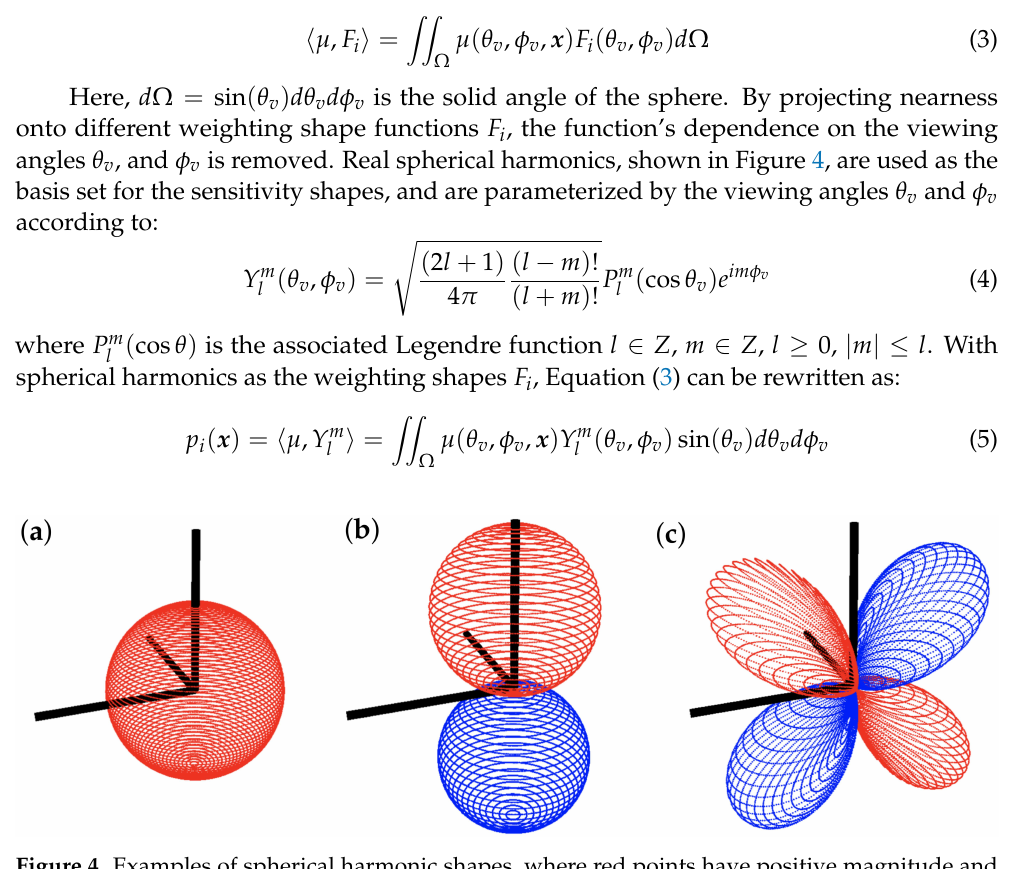
Mode ( b ) Y 1 Mode ( c ) Y 2 − 0 0 1